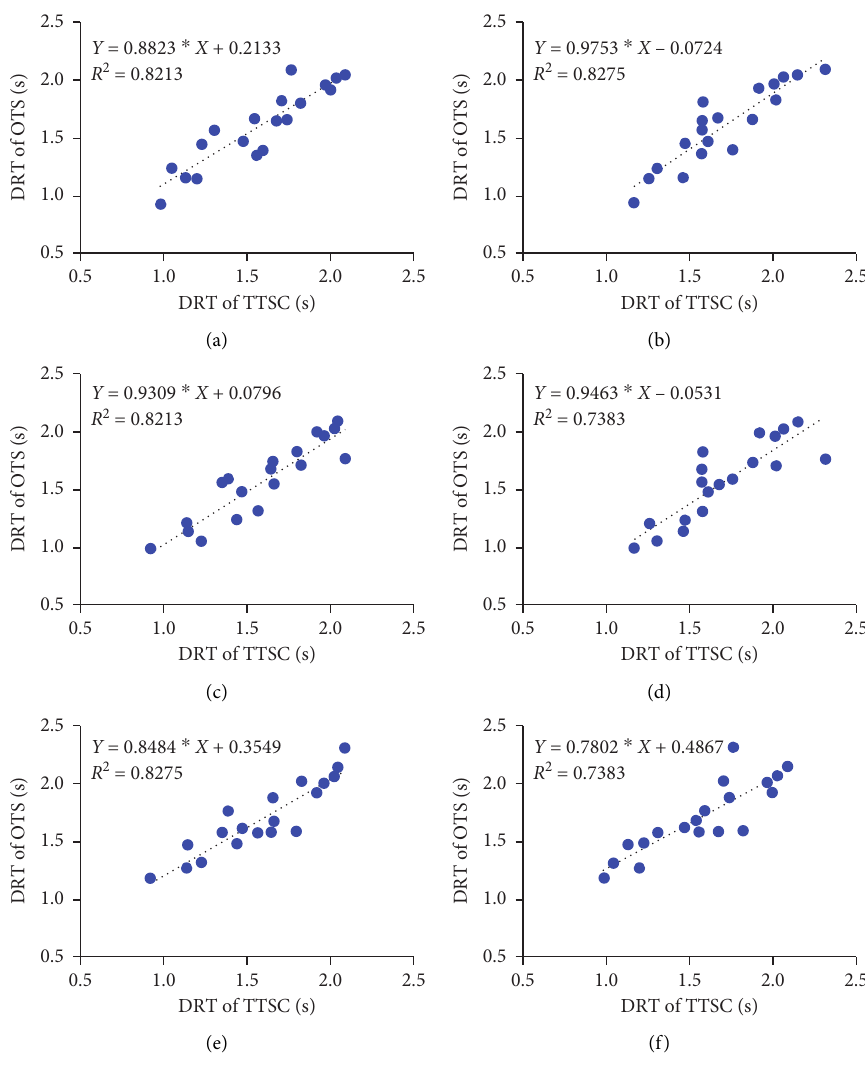
Figure 9: The scatter plot of DRT in DTSC.